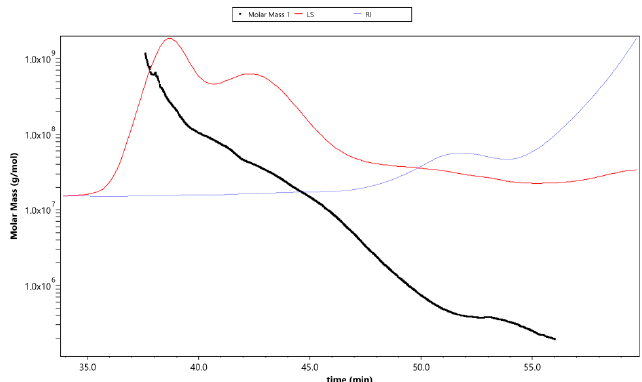
Figure 4. The variation tendencies of molar mass, laser scattering (LS), and refractive index (RI) of APS. The red line shows the varying tendency of the LS of APS with the retention time, and the blue line represents the trend of the RI of APS. The tendency of the red and blue lines indicates the size of the polysaccharide molecules and their relative proportions contained in the tested sample. The black line is the varying tendency of the molar mass of the polysaccharides following the retention time.